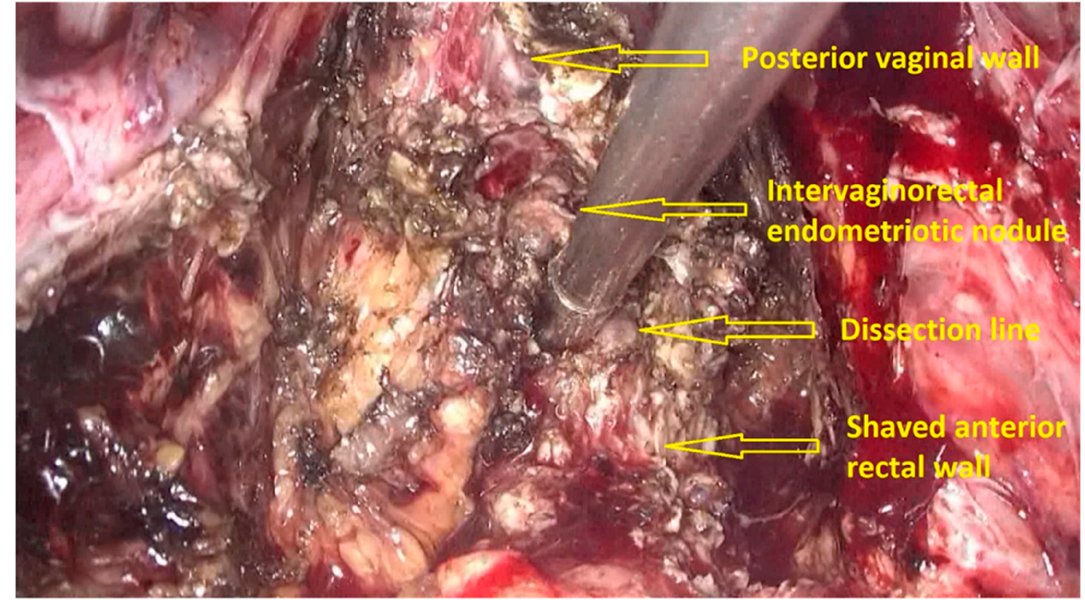
Figure 2. Laparoscopic view of the pelvis. ( a ) Inspection of the pelvic cavity and ( b ) identification of anterior rectal wall.